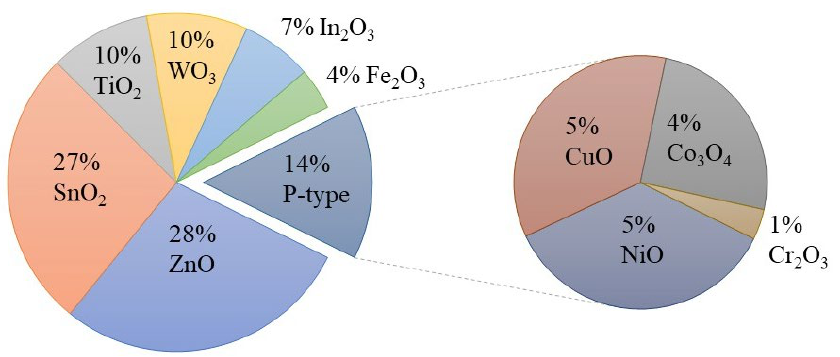
Figure 4. Use of metal oxides in gas-sensing applications from 2017 to 2022. Source: Web of Science.